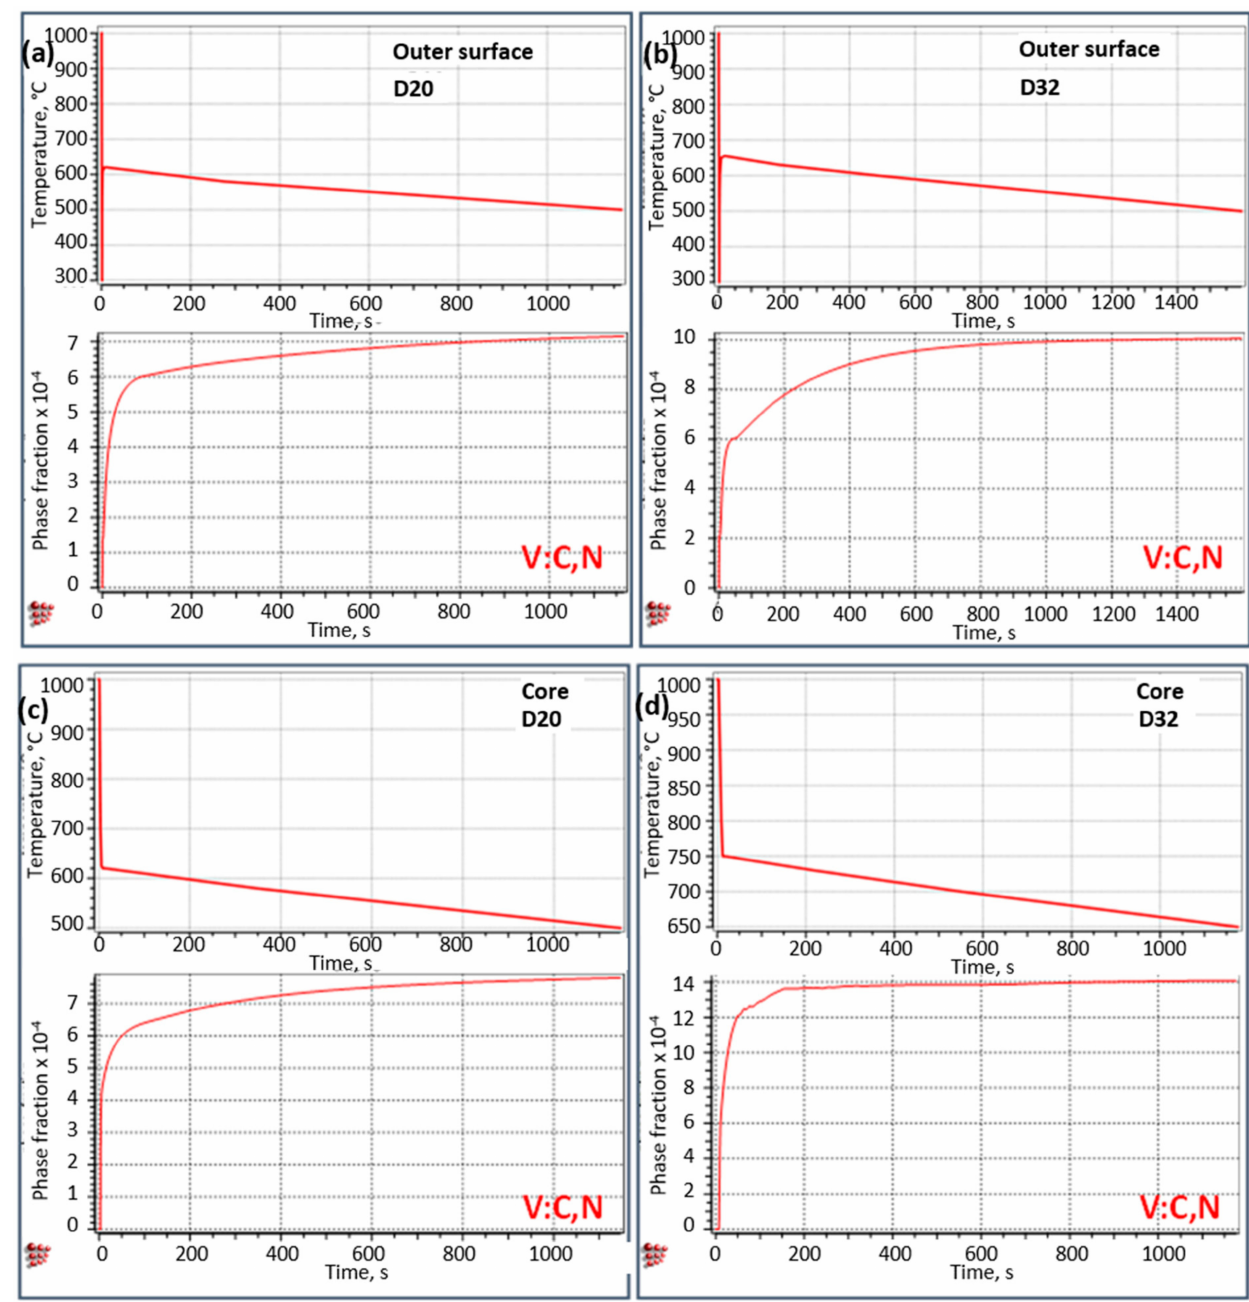
Figure 12. The precipitation kinetics during processing of D20 and D32 rebars for V-alloyed B500B steel grade. The thermal cycles and fraction of precipitation vs. time curves are represented in ( a – d ) for the outer surface D20, outer surface D32, core D20, and core D32,